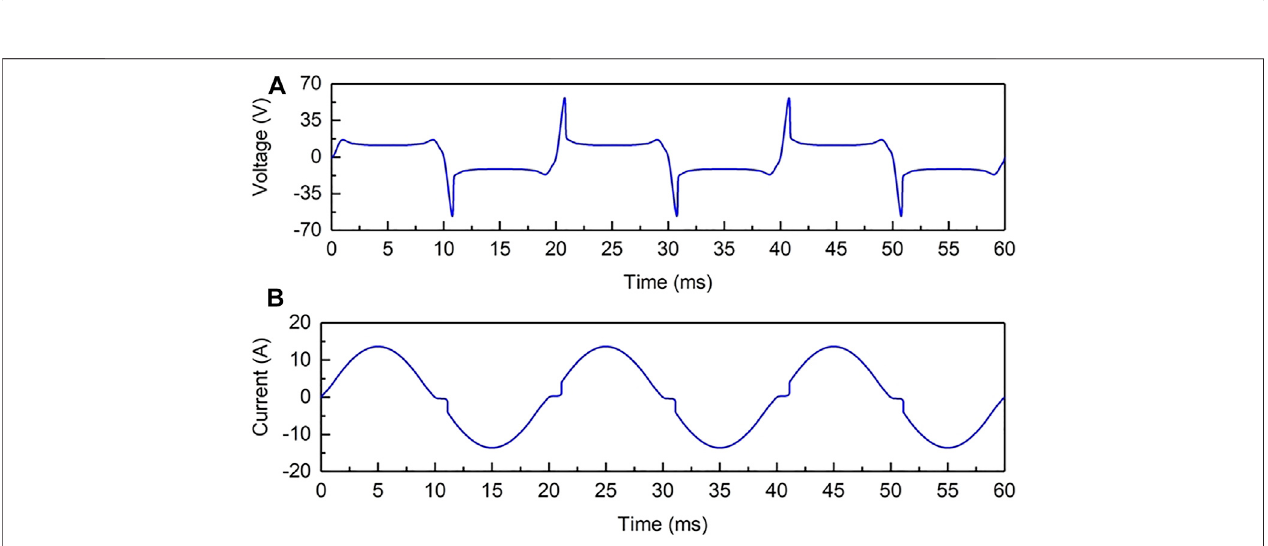
FIGURE 10 | Comparison between the method of this paper and a previous study (King-Jet Tseng et al., 1997). (A) Arc voltage; (B) arc current.